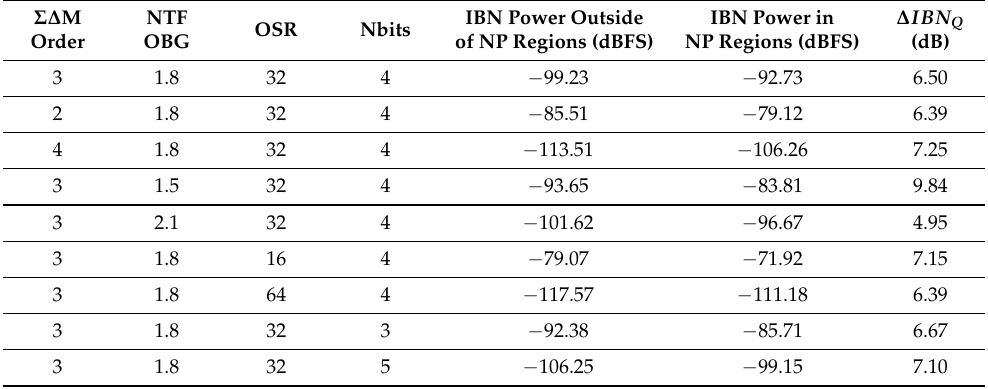
Figure 19. IBN power dependence on the number of levels due to quantization error. Σ∆ M parameters are: third-order, 4-bits, OSR = 32, OBG = 1.5. ( a ) Input and output signals. ( b ) In − band noise power. Output signal is divided in segments of 2.13 ms. Table 2. Influence of the Σ∆ M parameters on ∆ IBN Q